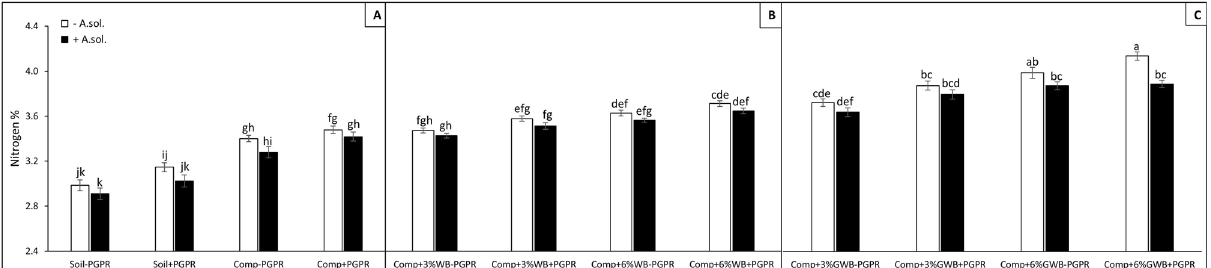
Figure 4. Effect of Alternaria solani and PGPR on percentage of nitrogen in leaf tissues of tomato raised in various soil substrate compositions including; ( A ) soil and compost (Comp) alone with (+ PGPR) and without PGPR (− PGPR), inoculated (+ A. solani ) or un-inoculated (− A. solani ), ( B ) compost (Comp) with 3 and 6% wood biochar (WB) with (+ PGPR) and without PGPR (− PGPR), inoculated (+ A. solani ) or un-inoculated (− A. solani ), ( C ) compost (Comp) with 3 and 6% Green waste biochar (GWB) with (+ PGPR) and without PGPR (− PGPR), inoculated (+ A. solani ) or un-inoculated (− A. solani ). All values represent mean ± SE, recorded 40 days after transplantation. Bars with different letters on the top suggest significant difference as per Tukey’s HSD test ( P ≤